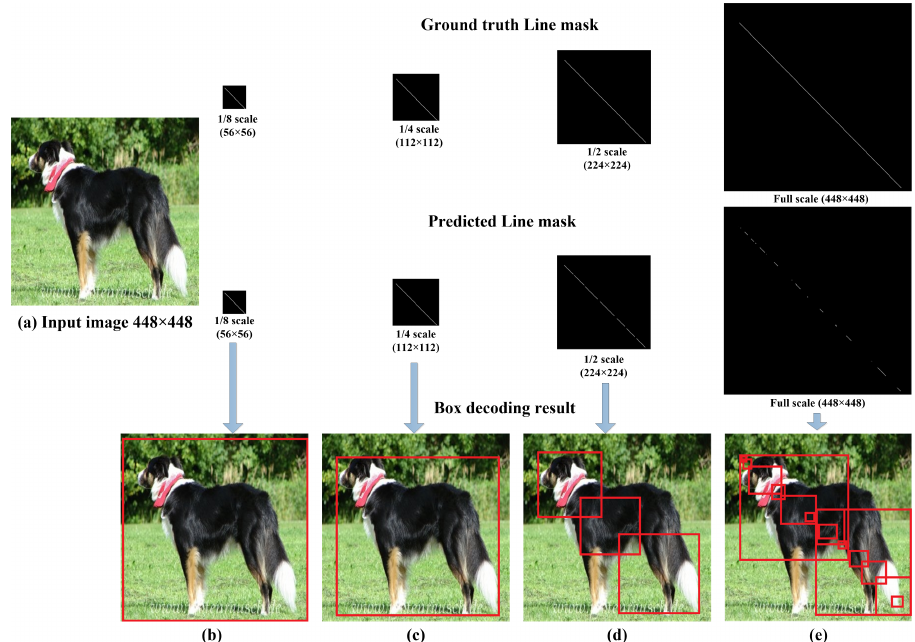
Figure 6. Comparison between the decoded boxes using different scales of the line masks during training and test. ( a – e ) show the input image and the decoded boxes using the predicted line masks of scales 1/8, 1/4, 1/2, and 1,